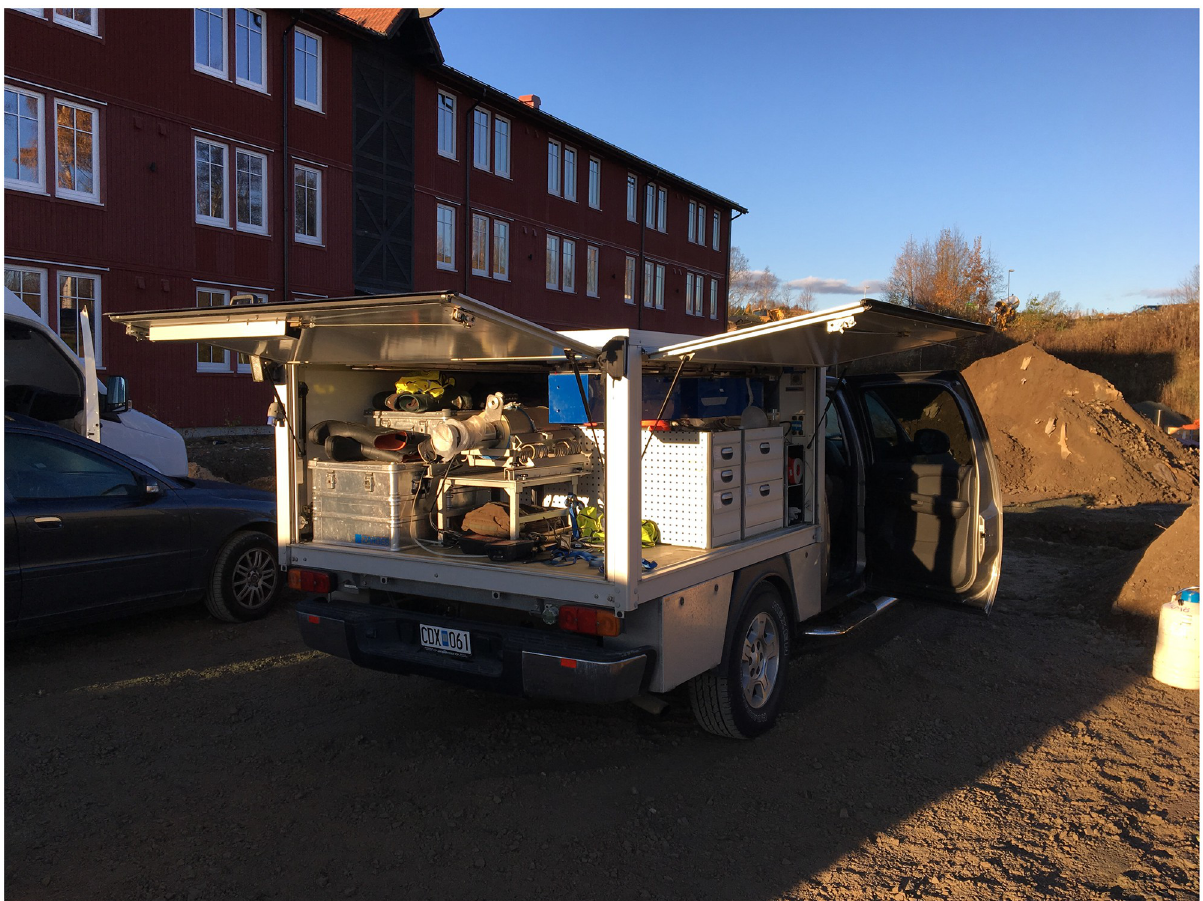
Fig 1. A picture of service-bed compartment of the gamma spectrometry vehicle used in the experiment. The 123% relative efficiency HPGe detector with its nitrogen dewar is visible in the centre-back of the service-bed. The two blue boxes in the upper-right part of the service-bed are the two 4l NaI(Tl) detectors. The GNSS receiver was mounted on the roof of the cabin, above the front passenger.